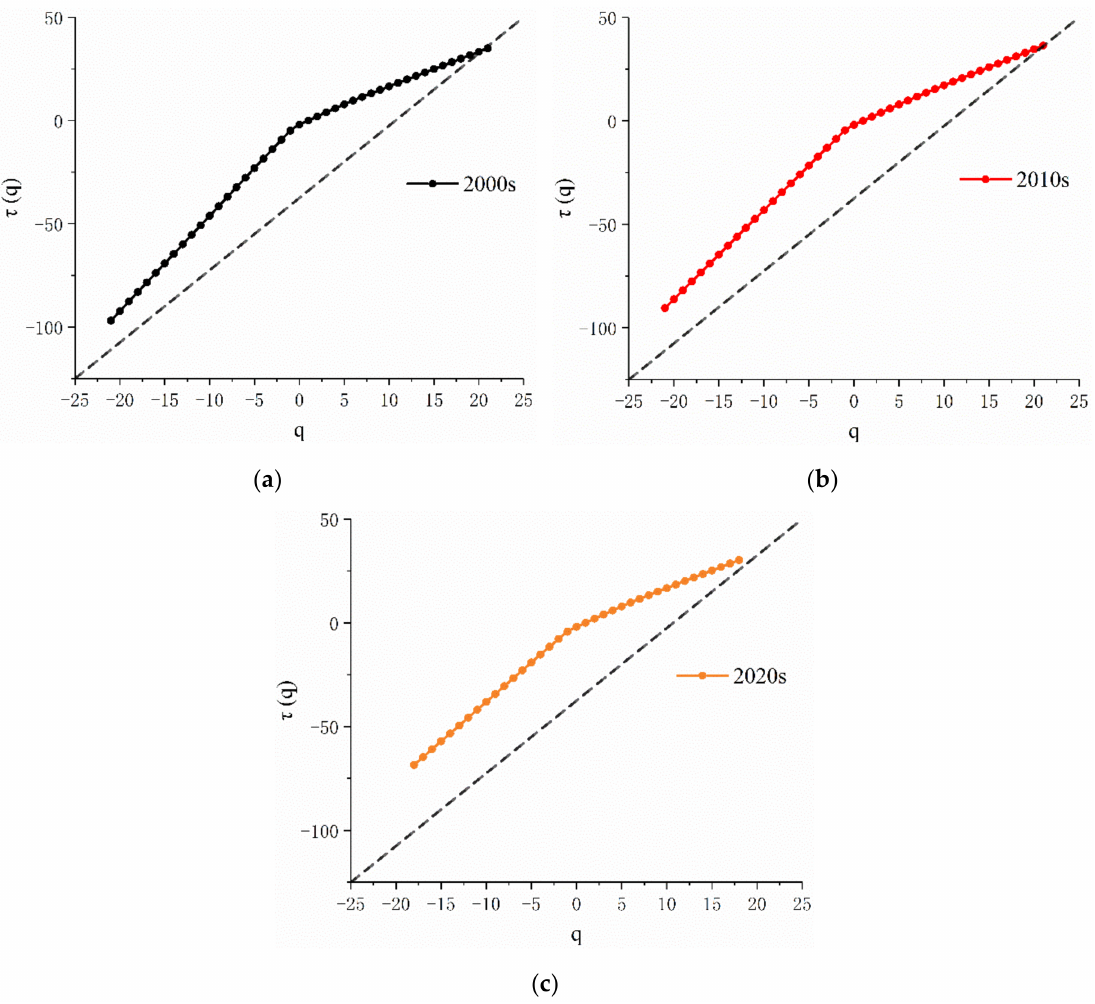
Figure 6. The relationship between τ (q) and q of the Yellow River Basin in the ( a ) 2000s, ( b ) 2010s, and ( c )